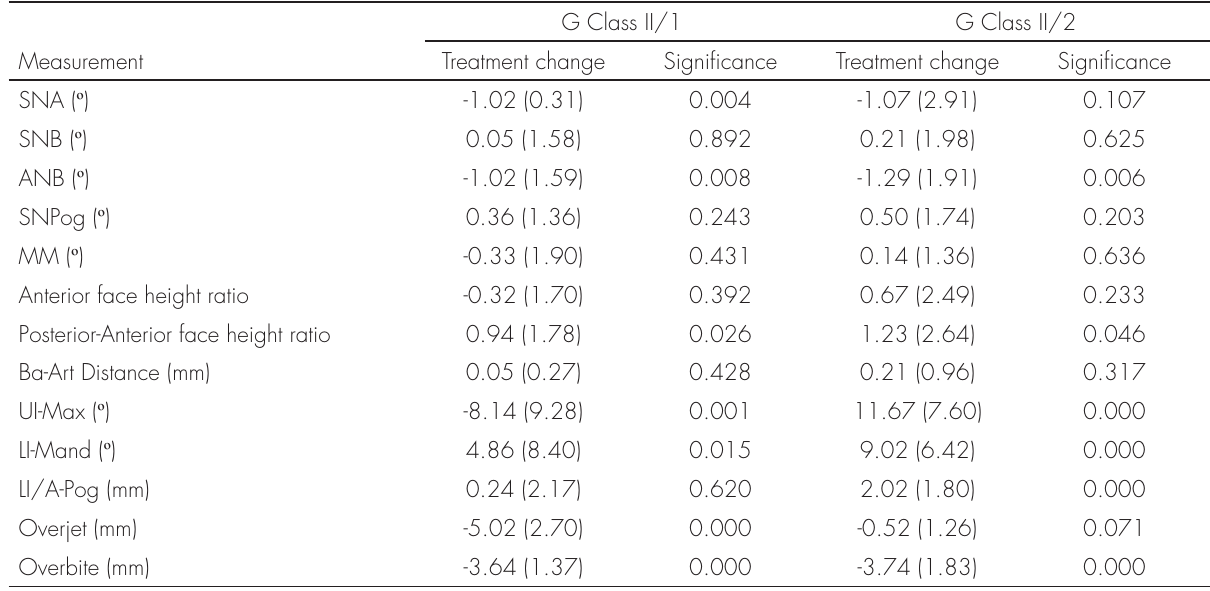
Minus sign indicates decrease in angular, linear or proportional measurements.